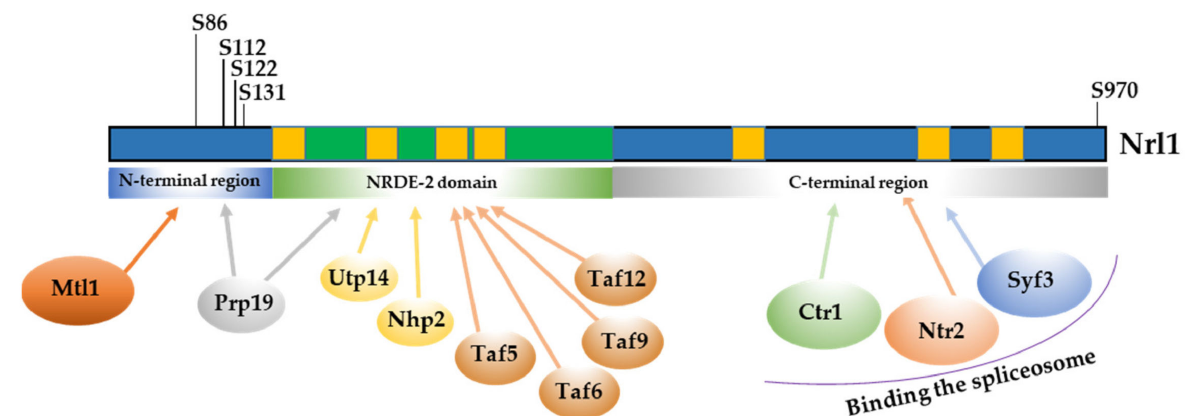
Figure 9. Schematic representation of the identified Nrl1 phosphorylation and domain-specific interactions of Nrl1 protein with various RNA-processing